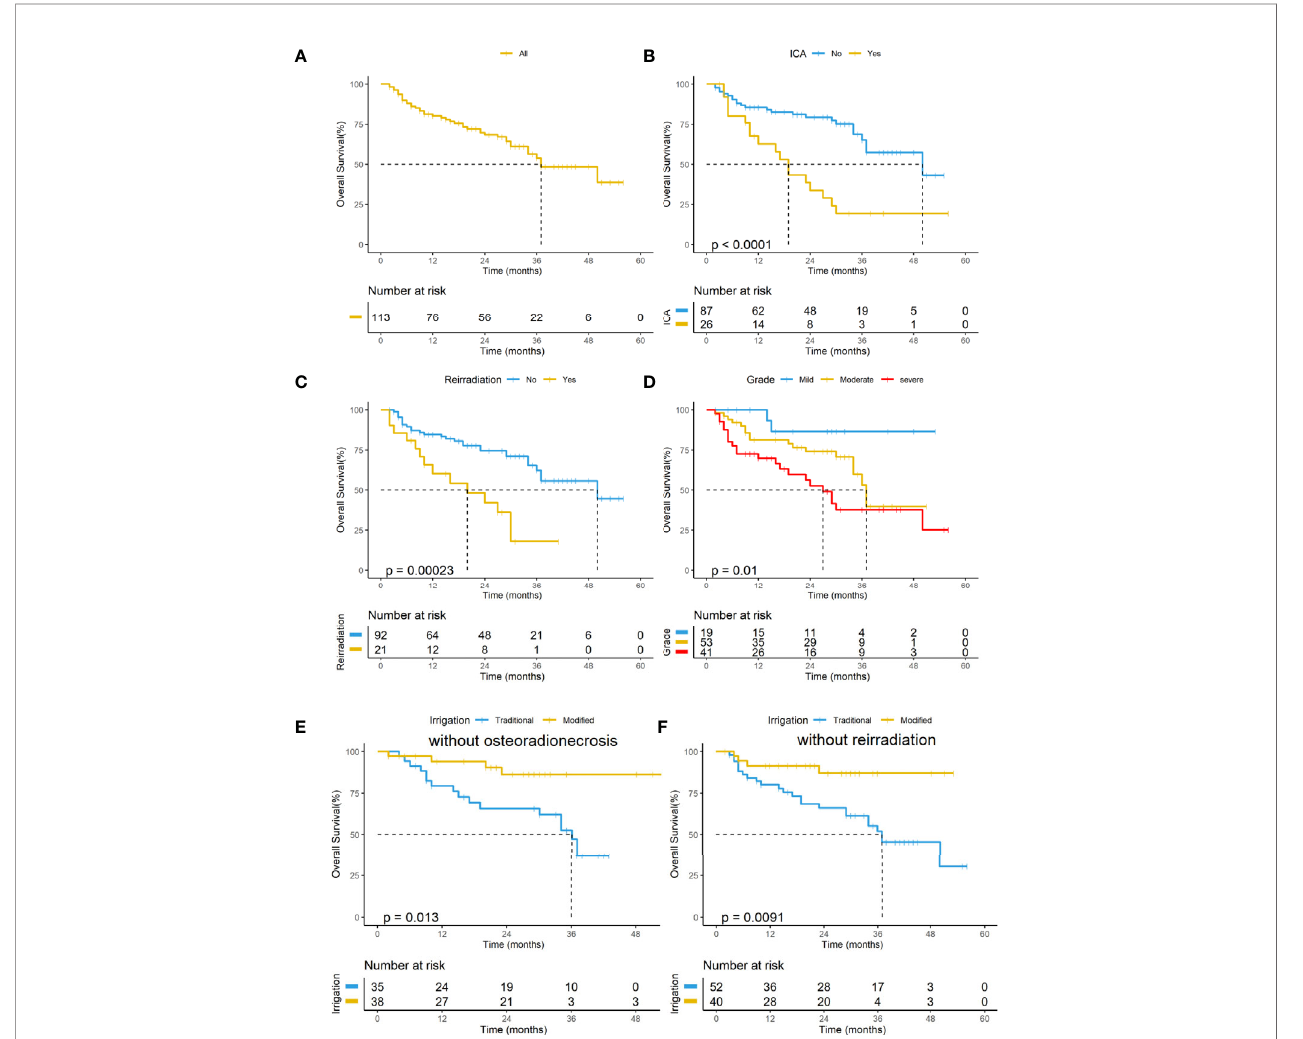
FIGURE 4 | Kaplan – Meier curves of overall survival for all patients with post-radiation nasopharyngeal necrosis (PRNN). (A) all patients. (B) patients strati fi ed by ICA exposure. (C) patients strati fi ed by re-irradiation. (D) patients strati fi ed by the grade of PRNN based on the standard classi fi cation system. (E) subgroup analysis for patients with mild- and moderate-grade PRNN based on to the standard classi fi cation system. (F) subgroup analysis for patients without re-irradiation. ICA, internal carotid